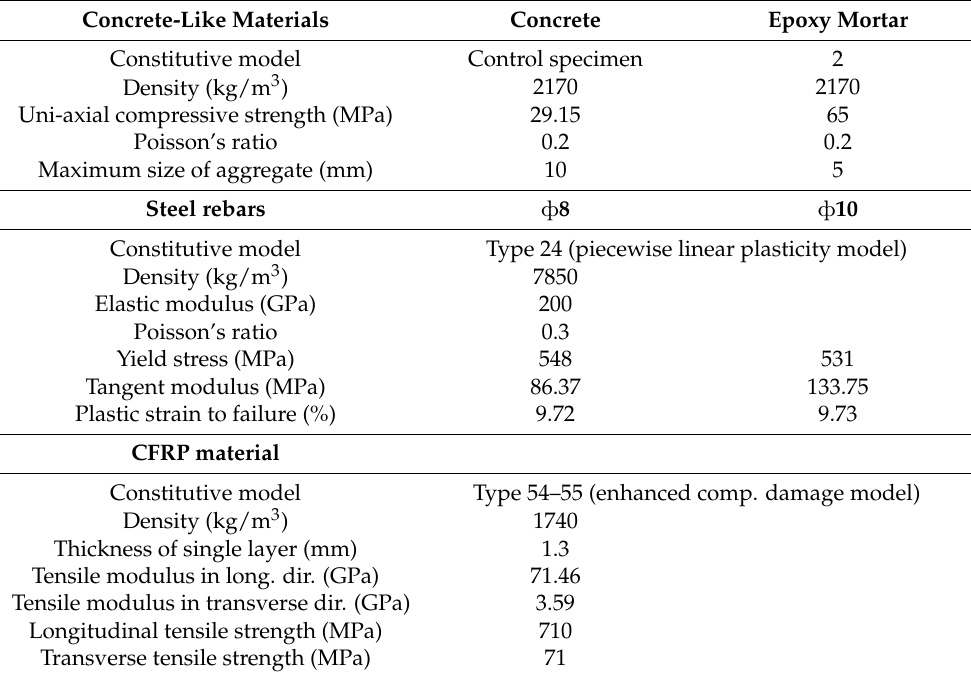
Table 2. Properties of constituent materials employed in FEA. Concrete-Like